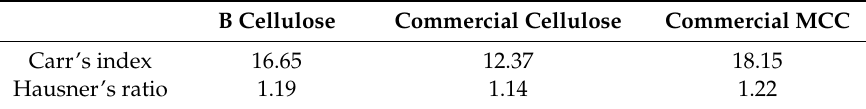
Table 2. Carr’s index and Hausner’s ratio average for all three excipients.